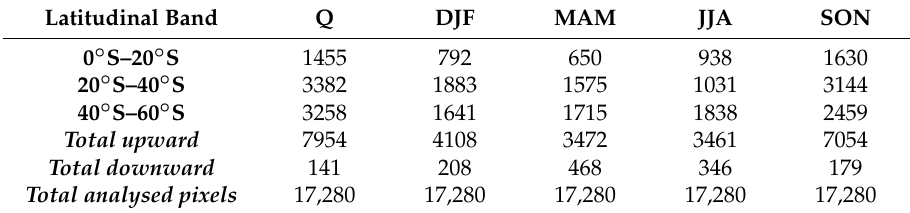
Table 4. As in Table 1 but for the NO 2 concentrations in the Trop.